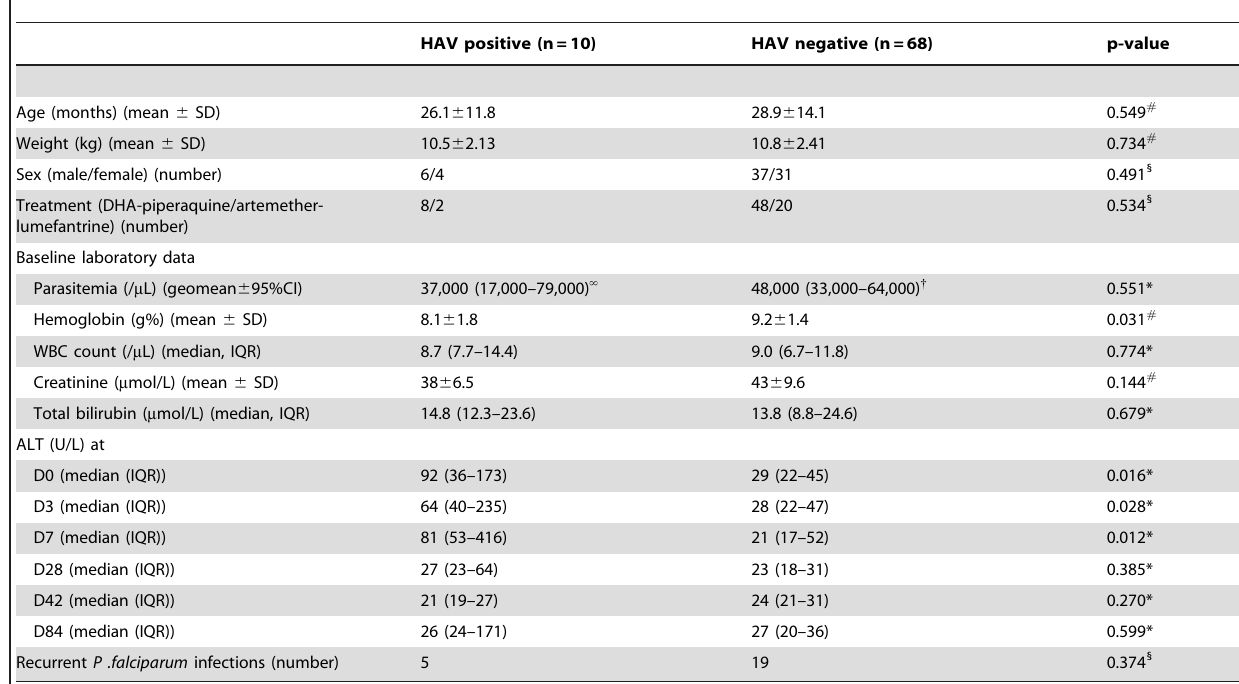
Table 1. Comparison of HAV positive and negative patients presenting with uncomplicated P. falciparum